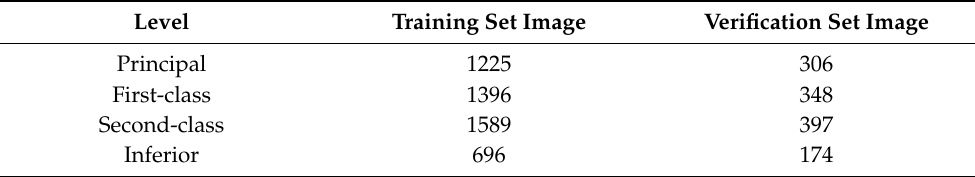
Table 2. Dataset partition.